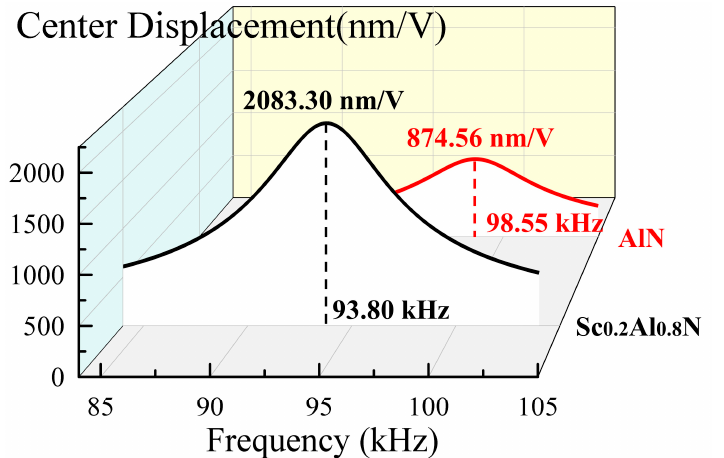
Figure 2. The FEM simulation dynamic mechanical amplitude for 500 µm diameter ScAlN and AlN bimorph PMUT.